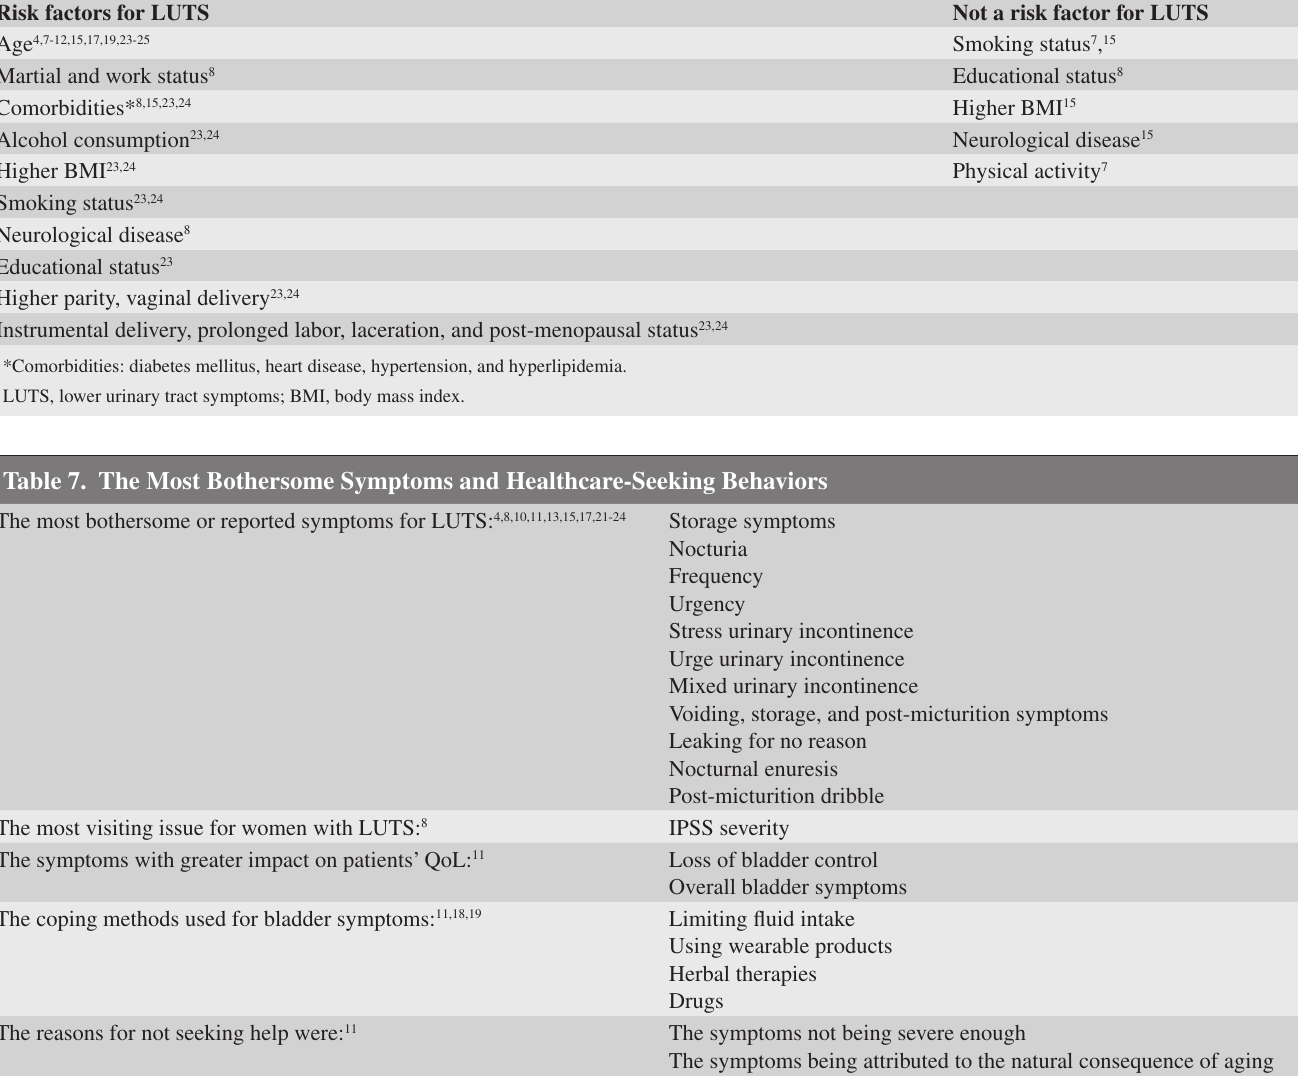
Table 6. Risk Factors for Lower Urinary Tract Symptoms (LUTS) in Women Risk factors for LUTS